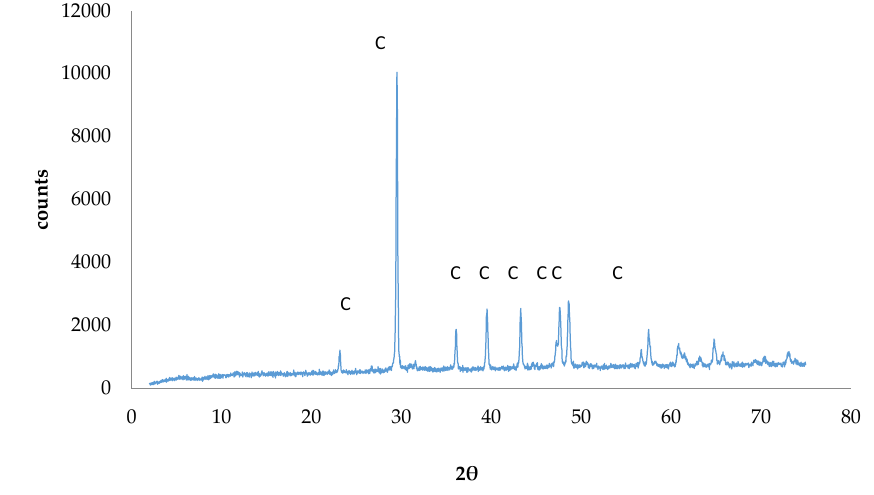
Figure 14. XRD diagram of CSF, where C: calcite.